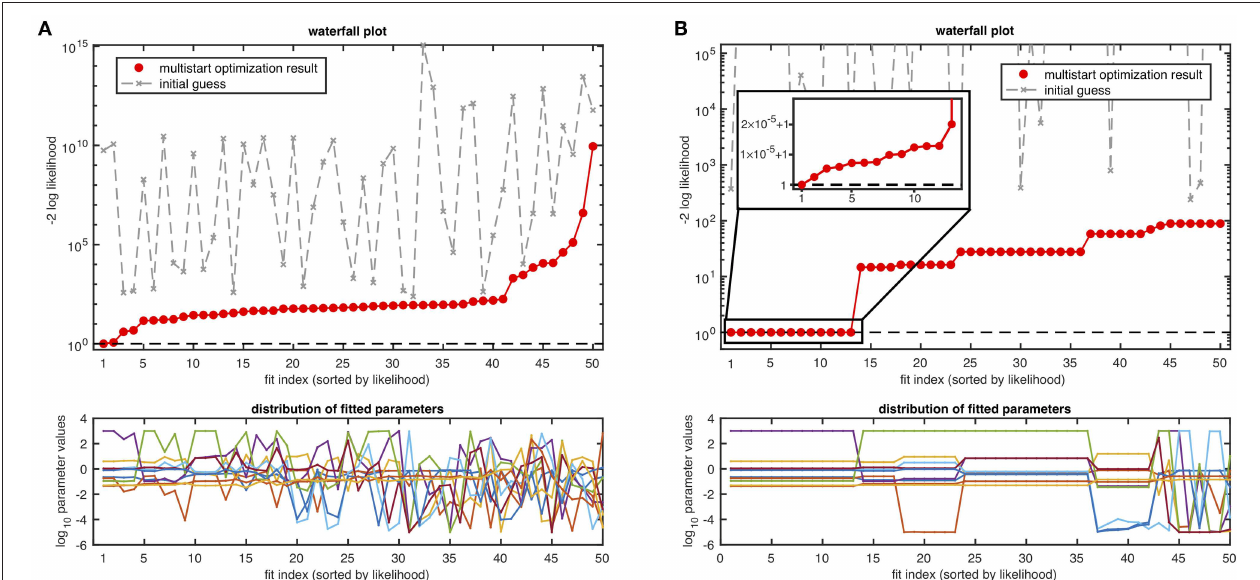
FIGURE 4 | Waterfall plot and distribution of parameters of fits from the same 50 randomly sampled initial guesses in (A) with the suboptimal optimization setup and in (B) with the standard optimization setup using the JAK/STAT signaling model with ten estimated parameters. For illustration, likelihood values are shifted to the baseline of one by subtraction of the likelihood value for the global minimum.